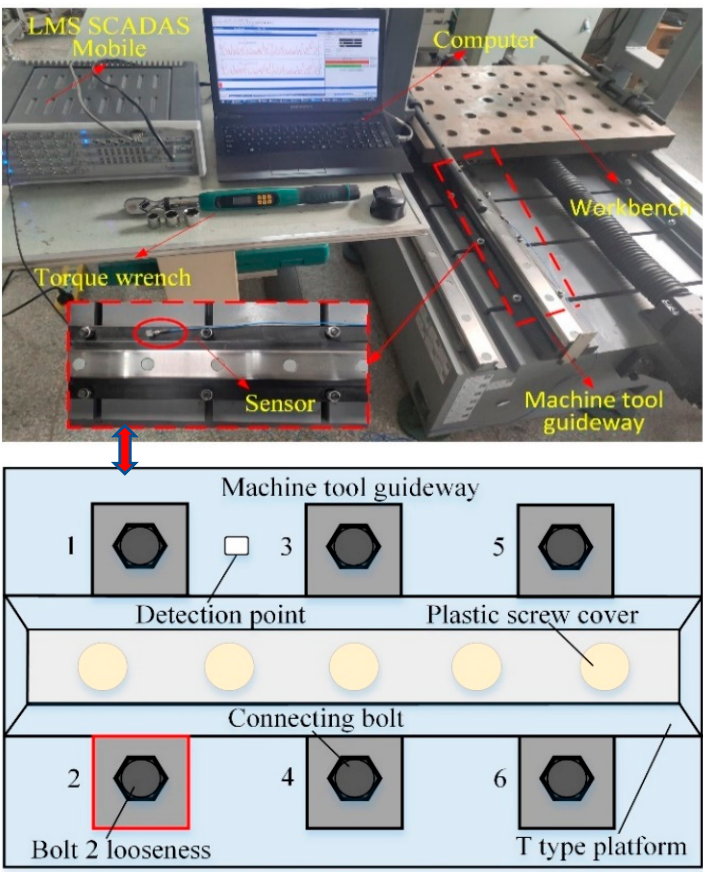
Figure 4. Experimental setup for bolt loosening.